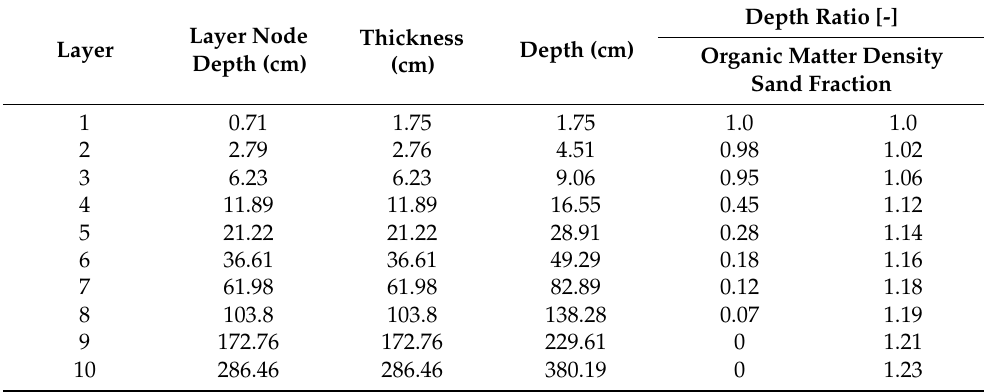
Table 1. Soil layer node depth, thickness and depth at the layer interface for the ten layers in the